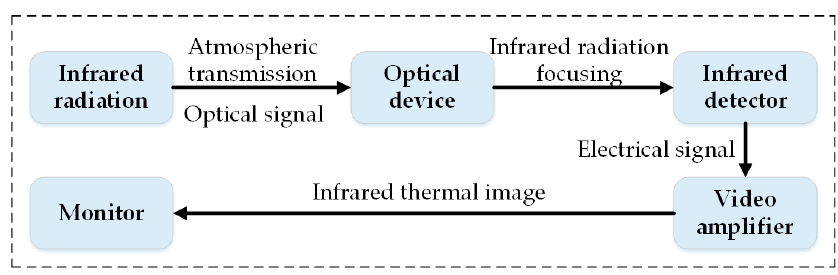
Figure 5. The structure and imaging principle of the infrared thermal camera.